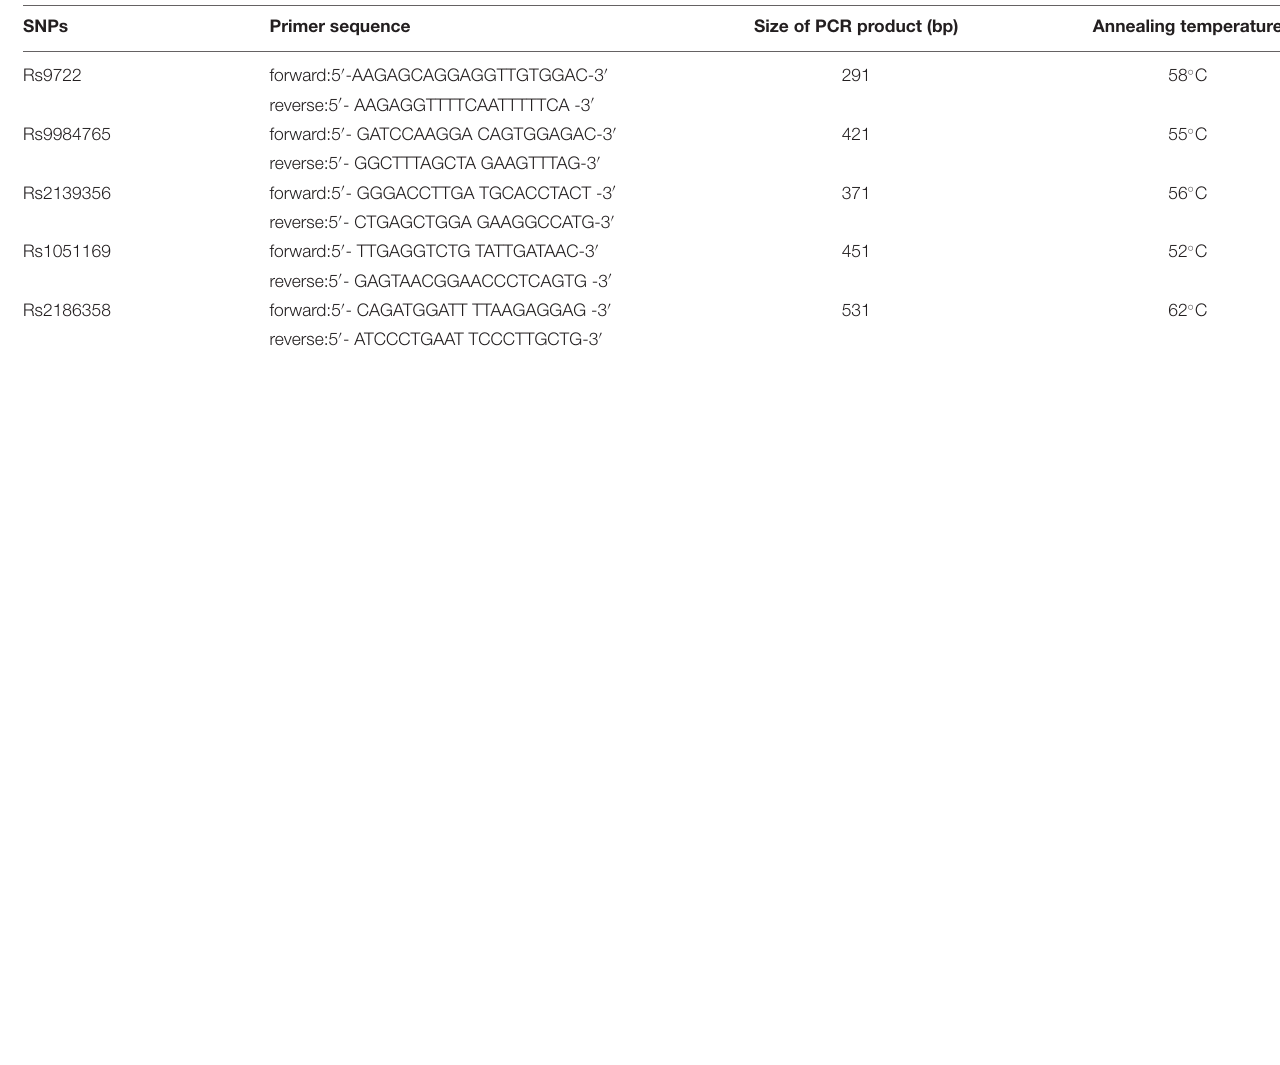
Table A1 | Primer Sequence used in genotyping S100B